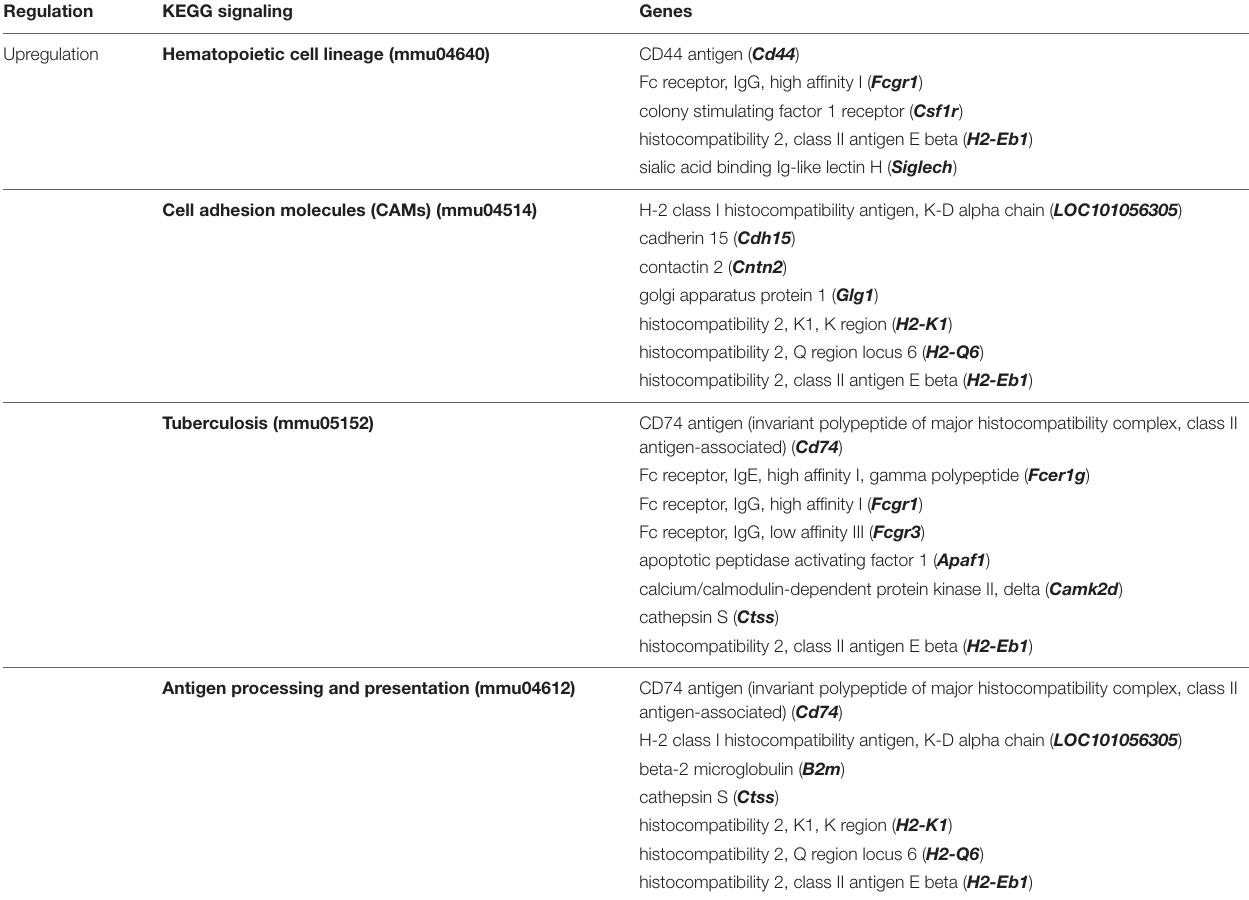
TABLE 3 | Top significantly enriched KEGG signaling pathways in Hippocampus of LPS-induced depression mice (LPS) compared to untreated normal mice